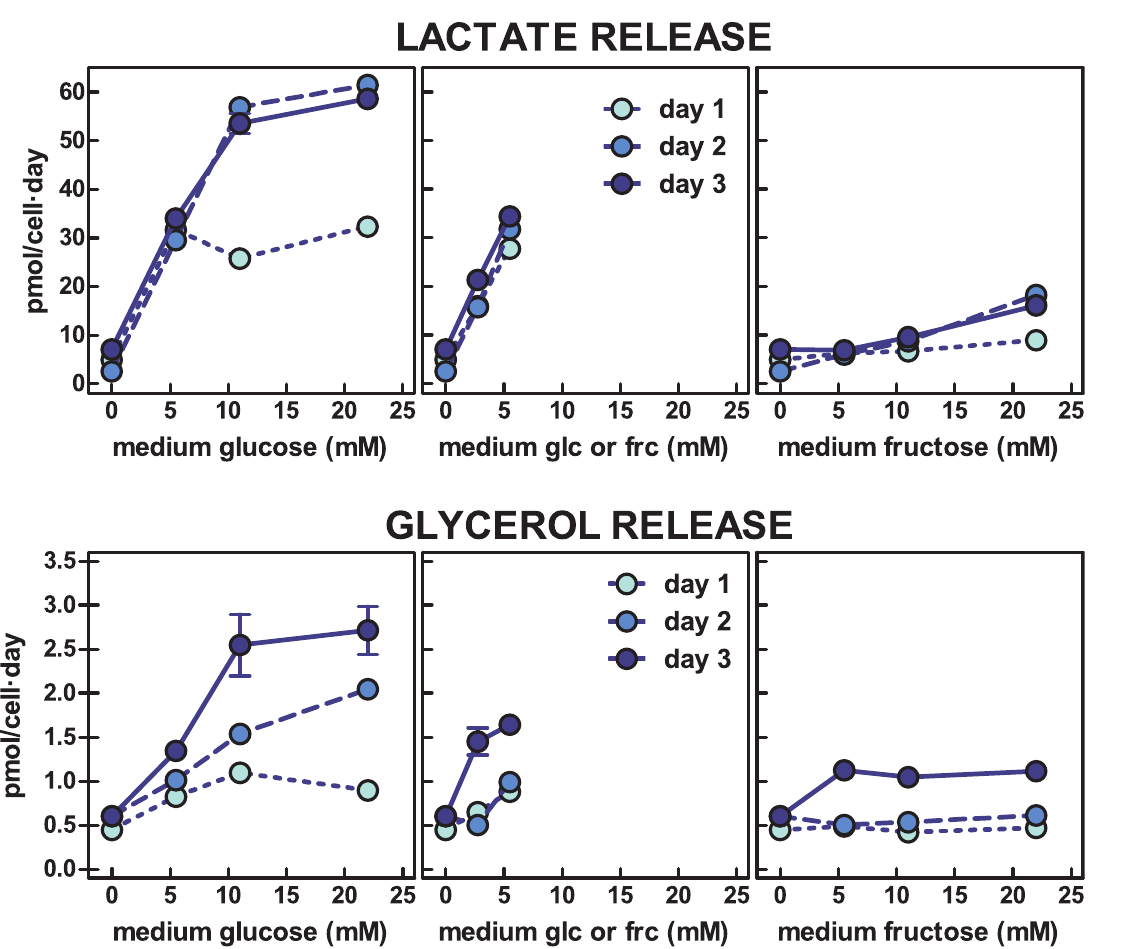
Fig 3. Lactate and glycerol efflux from 3T3-L1 adipocytes exposed to a medium with varying concentration of glucose, fructose or a combination of both. Each dot represent the mean ± sem of three different wells. Lactate or glycerol release are expressed in pmol per cell and day. There were statistically significant (two-way anova) differences (P < 0.05) for lactate release at 11 mM and 22 mM glucose on day 1 vs. days 2 and 3. There were significant differences for concentrations from 5.5 mM onwards in the production of lactate from medium fructose compared with glucose for all three days. Glycerol release showed significant differences for 22 mM glucose on days 1 vs 2 and 3 and for 11 mM glucose for day 1 vs day 3. There were significant differences between glycerol release from fructose vs. glucose at 11 mM and 22 mM for days 2 and 3. In the graphs where glucose + fructose were present in the medium, the X-axis legend shows the concentration of each of both